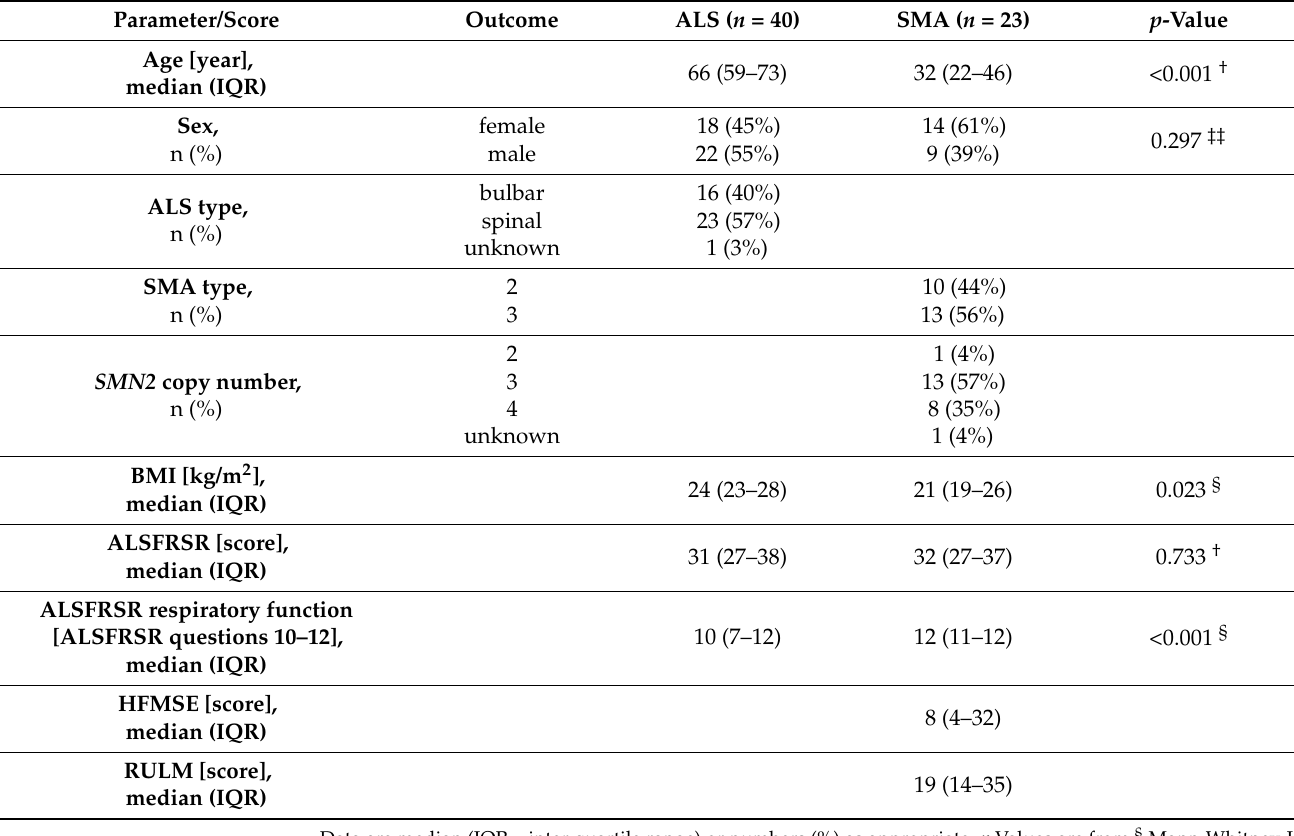
Table 1. Demographic and clinical characteristics of study